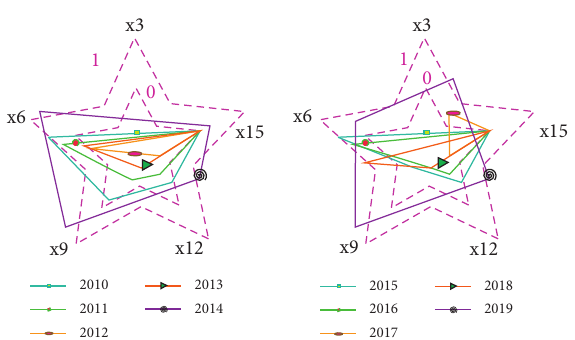
Figure 6: Comprehensive utilization status evaluation of waste.